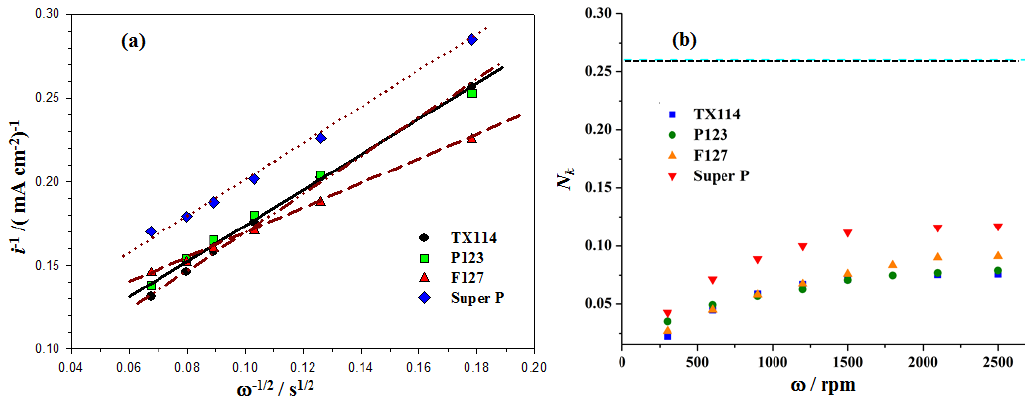
Figure 4. RRDE profiles for Mn 3 O 4 /C composites and Super P (SP), recorded at 50 mV·s −1 in an O 2 - saturated 0.1 M TBAPF 6 /propylene carbonate (PC) solution, at rotation rates between 300 and 2100 rpm (the Pt ring is maintained at 2.6 V Li : ( a ) TX114; ( b ) P123; ( c ) F127; and ( d ) Super P.